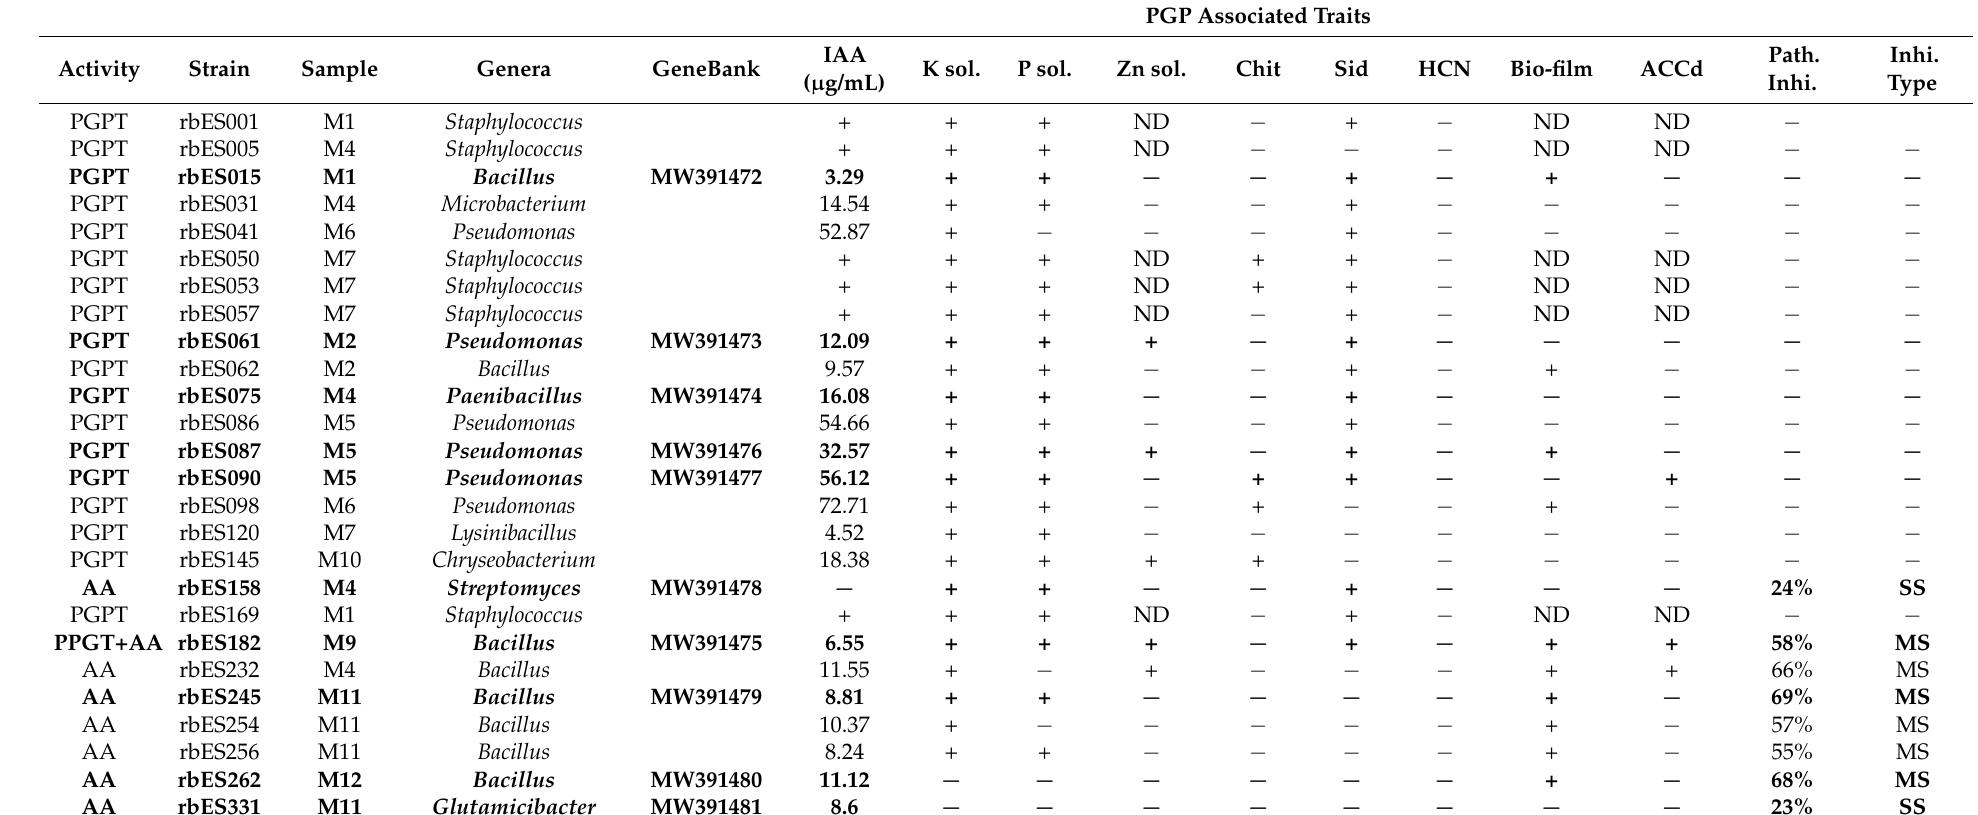
Table 1. Plant growth promotion associated traits of selected